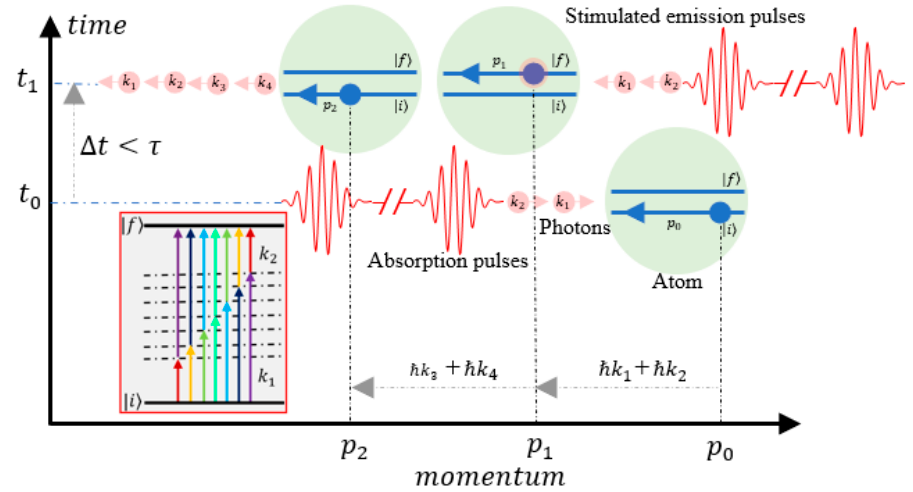
Figure 2. Stimulated emission scheme in the momentum–time space, the atoms at ( p 0 , t 0 ) lose a momentum of ℏ (𝒌 𝟏 + 𝒌 𝟐 ) during the TP absorption process (inset); after a time delay of less than the lifetime τ , the excited atoms at ( P 1 , t 1 ) lose another momentum of ℏ (𝒌 𝟑 + 𝒌 𝟒 ) during the TP stimulated emission process, and the total momentum transfer or loss of the atoms is ℏ (𝒌 𝟑 + 𝒌 𝟒 + 𝒌 𝟏 + 𝒌 𝟐 ) in one absorption-stimulated emission cycle.